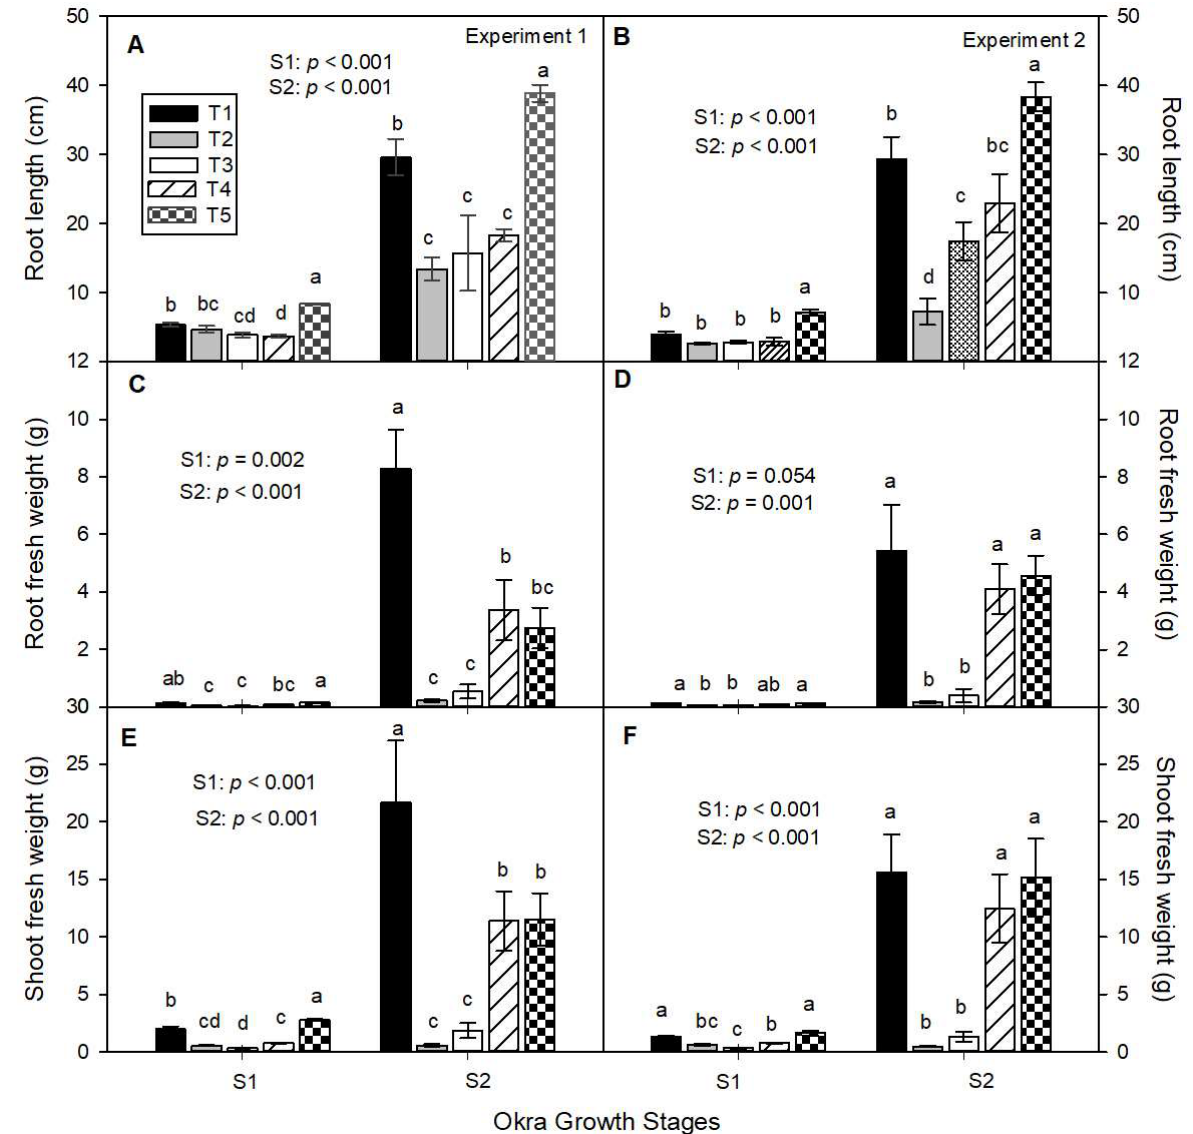
Figure 2. Effect of non-composted Bombax ceiba (red cotton tree) sawdust substrates on Abelmoschus esculentus L. (okra). Length of root (cm) ( A , B ), fresh weight of root (g) ( C , D ), and fresh weight of shoot (g) ( E , F ), at two plant growth stages; S 1 (30 days after sowing) and S 2 (110 days after sowing) in two independent experiments. All treatments (T 1 , T 2 , T 3 , T 4 , T 5 ) were the same as described in Figure 1. Different letters display significant differences between treatment mean values at the top of the vertical bars, as determined by the least significant difference test (LSD) at p < 0.05. Differences between treatments were very significant, as evidenced by the p < 0.001. The error bars show the standard error ( n =